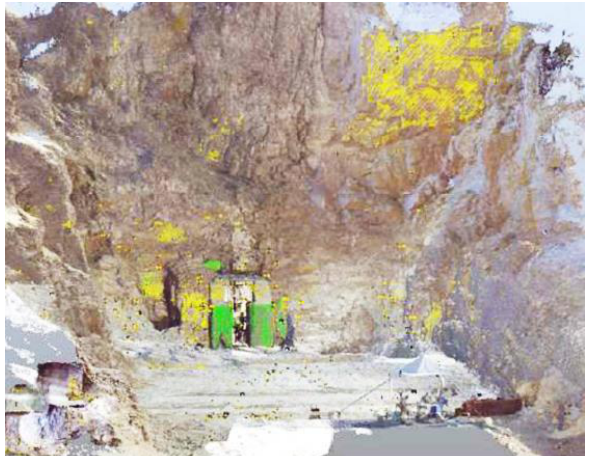
Figure 6: First approaches to excavation. Image generated by the 3d scanner from access to the funeral complex, 2017.